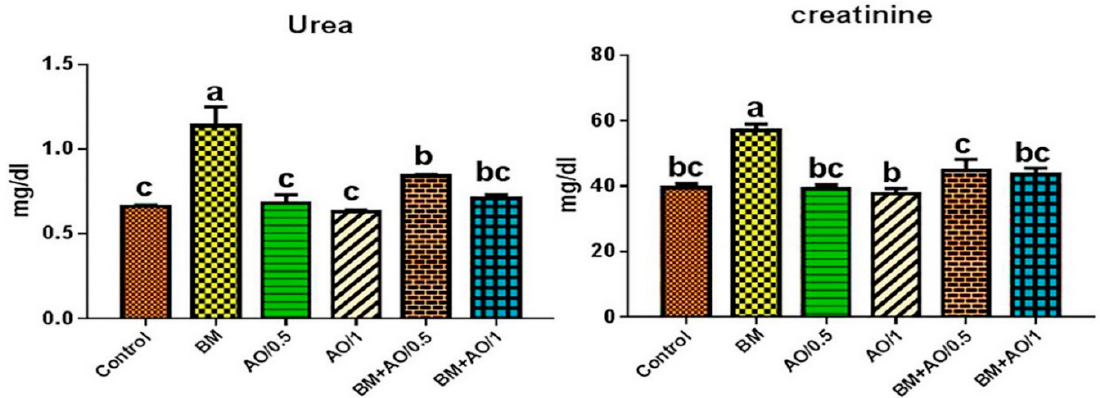
Figure 1. Effect of betamethasone and/or argan oil on serum renal function biomarkers of different treated groups ( n = 8). Different superscripts (a,b,c) indicate significant differences at p < 0.05. BM: betamethasone, AO: argan oil.